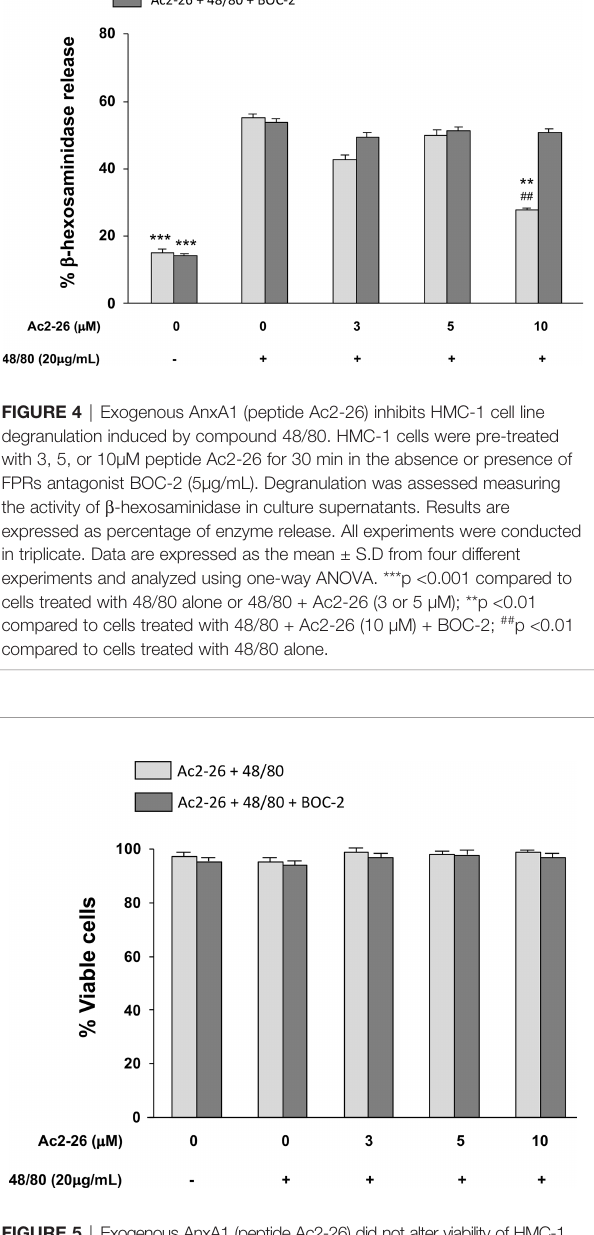
FIGURE 5 | Exogenous AnxA1 (peptide Ac2-26) did not alter viability of HMC-1 cell line. Cells were pre-treated with 3, 5, or 10µM peptide Ac2-26 for 30 min in the absence or presence of FPRs antagonist BOC-2 (5µg/mL). The cells were then stimulated with 20 µg/mL compound 48/80 for 30 min. Cell viability was assessed by trypan blue exclusion assay and results are expressed as percentage. All experiments were performed in triplicate. Data are expressed as the mean ± S.D from four different